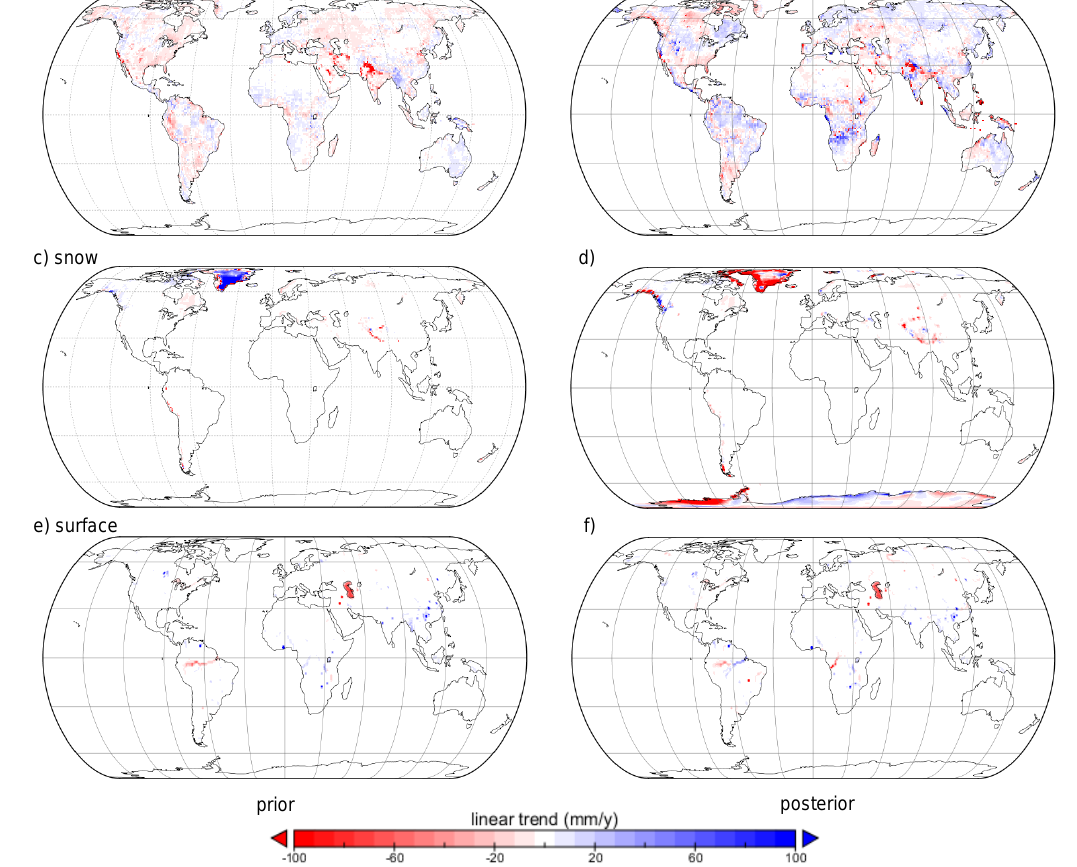
Figure 5. Trends in seasonal anomalies of prior (left column) and posterior (right column) estimates of (a–b) subsurface, (c–d) snow and (e–f) surface (i.e. lake and river) water